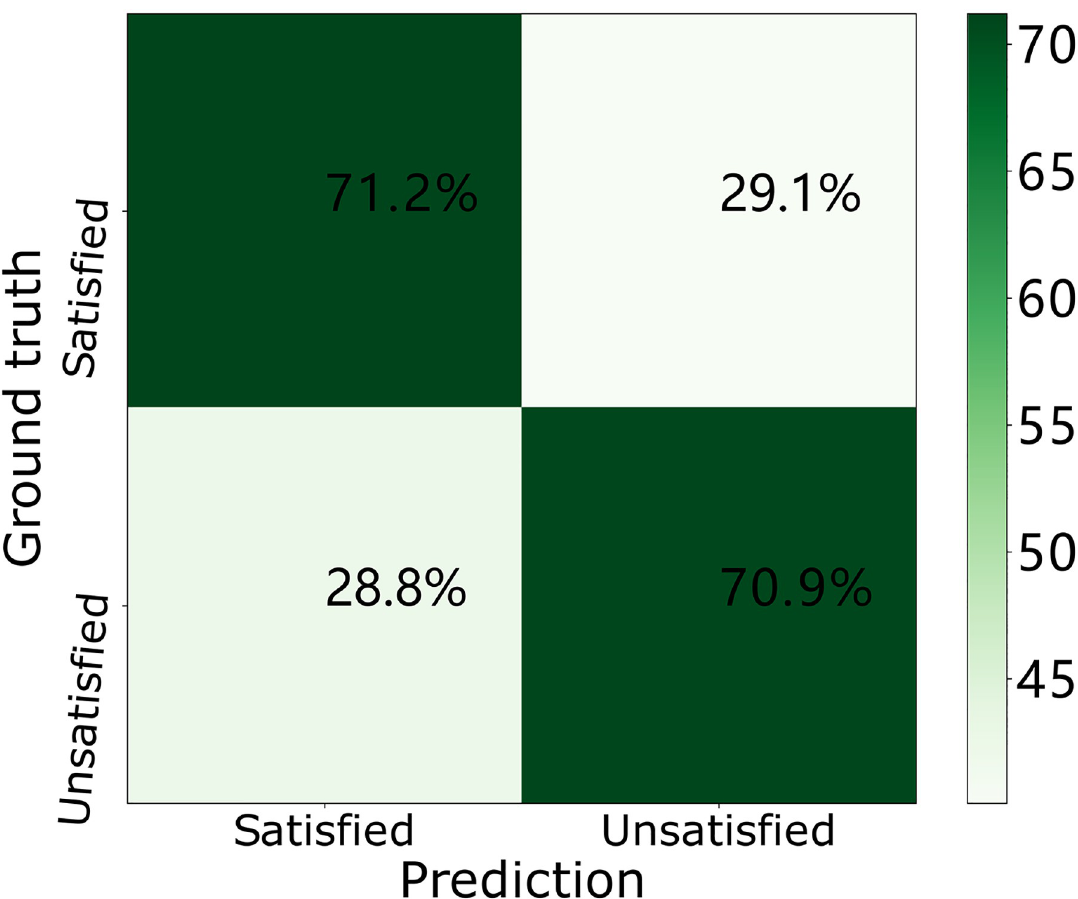
Fig 8. Confusion matrices of our DNN model over the ESI dataset in the validation phase.